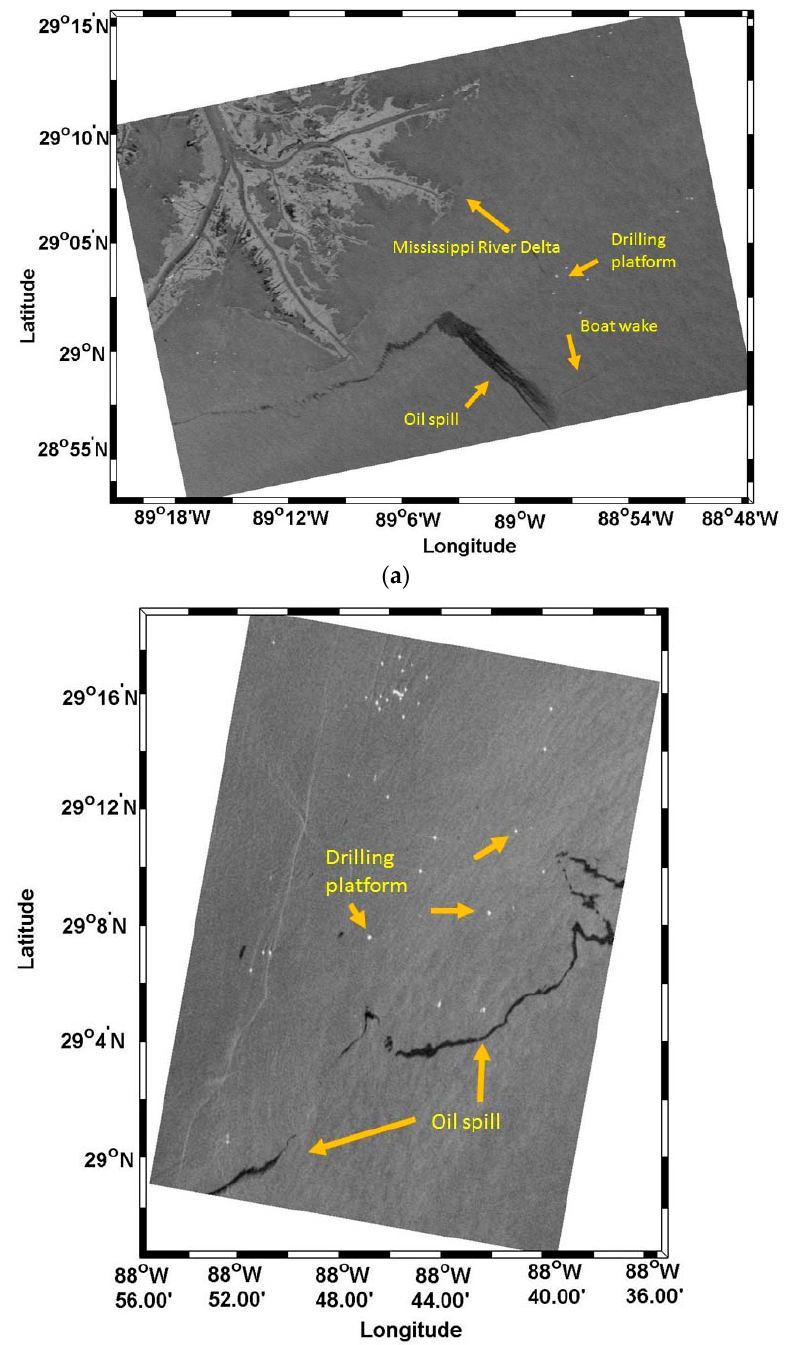
Figure 1. The ocean oil spill image of RadarSat-2 in fine quad-polarization imaging mode used in this study: ( a ) oil spill image of RadarSat-2 SAR (Dataset 1); and ( b ) oil spill image of RadarSat-2 SAR (Dataset 2). There are oil spill, water, island, and oil platform in the image of Dataset 1, and there are oil spill, water and oil platform in the image of Dataset 2.